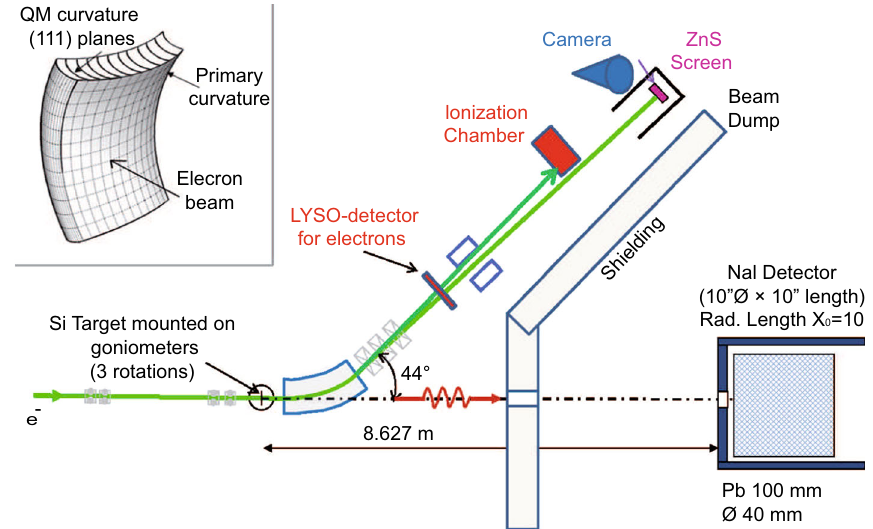
Fig. 1 Scheme of the experimental setup at MAMI B. After the inter- action with Si target mounted on a high precision goniometer, the 855 MeV electron beam is deflected horizontally by a bending mag- net. A LYSO detector downstream of the crystal measures the beam distribution after interaction. Then a ionization chamber is positioned after a second dipole-magnet, which deflects particles along the vertical direction. It is employed to detect channeling. Just in front of the beam